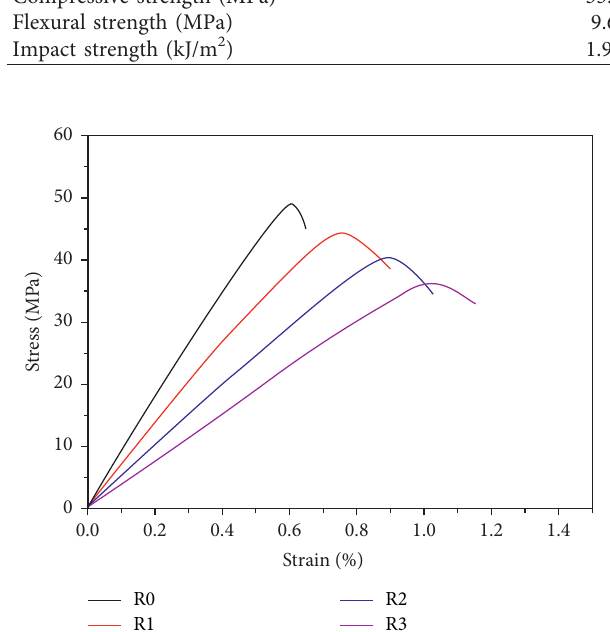
Figure 6: Stress-strain behavior of cement